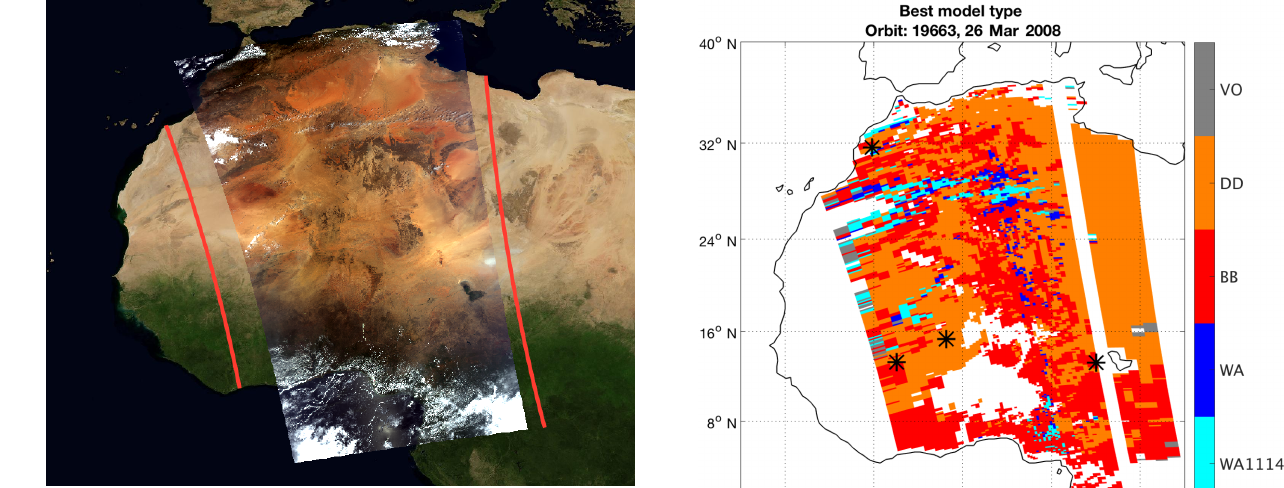
Figure 8. Merged true-colour Aqua/MODIS image (RGB) on 26 March 2008 at 13:00 and 13:05UTC. The area of the analysed OMI pixels is marked with red contours.